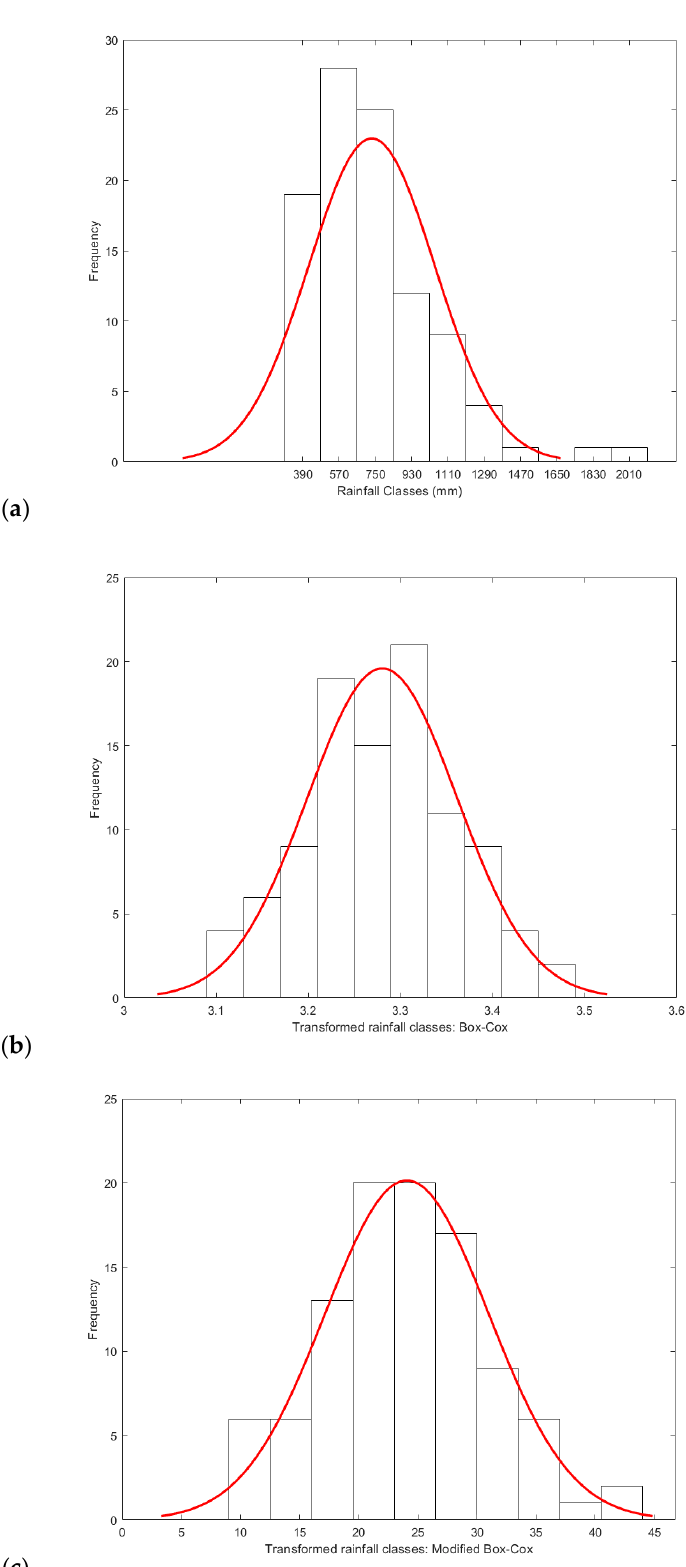
Figure 2. Histograms, which fitted the gaussian curve (red), of rainfall data ( a ) and of transformed values using Box-Cox ( b ) and Modified Box-Cox ( c ) methods.